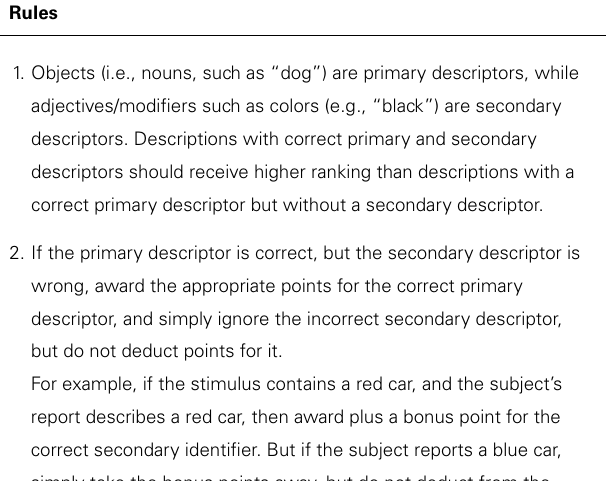
Table 1 | Selected special case